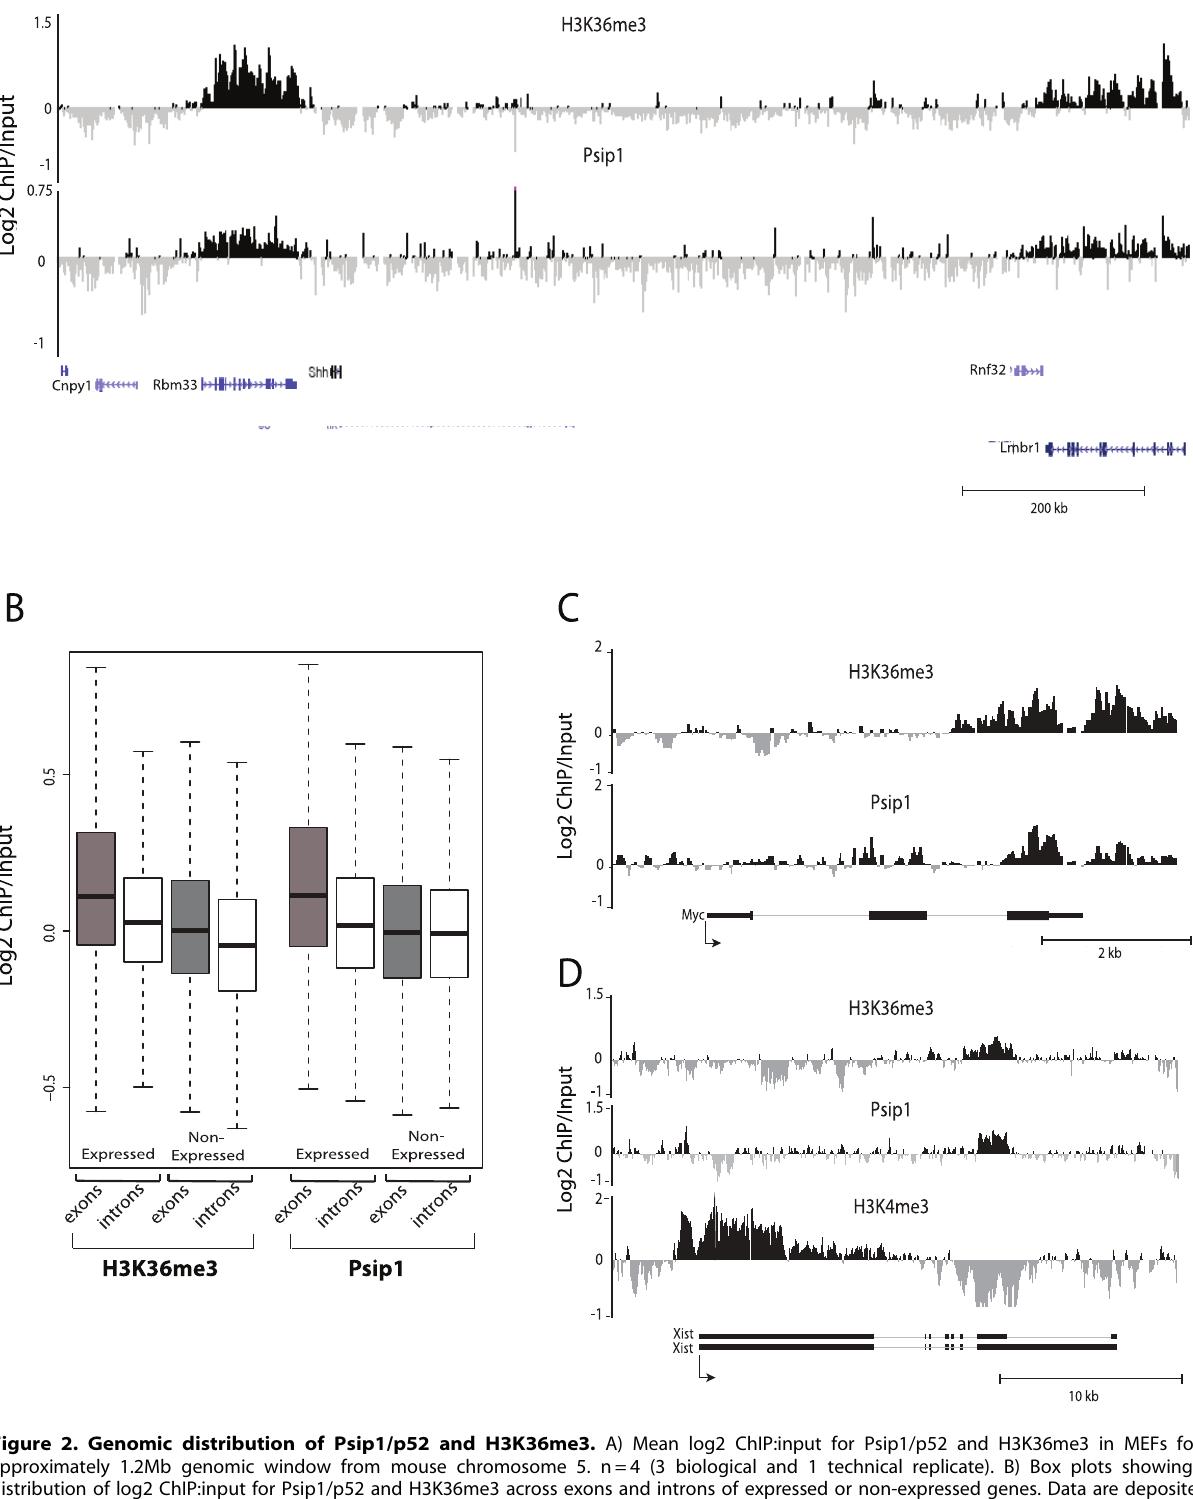
Figure 2. Genomic distribution of Psip1/p52 and H3K36me3. A) Mean log2 ChIP:input for Psip1/p52 and H3K36me3 in MEFs for an approximately 1.2Mb genomic window from mouse chromosome 5. n=4 (3 biological and 1 technical replicate). B) Box plots showing the distribution of log2 ChIP:input for Psip1/p52 and H3K36me3 across exons and introns of expressed or non-expressed genes. Data are deposited in NCBI GEO (Accession no. GSM697402-GSM697411). C, D) Mean log2 ChIP:input for Psip1/p52 and H3K36me3 in MEFs at (C) c- Myc and (D) Xist loci. H3K4me3 is also shown for XIST. Filled boxes indicate the positions of exons. n=4 (3 biological and 1 technical replicate) for H3K36me3 and Psip1. NCBI GEO accession number for array platform is GPL13276. n=2 biological: replicates for H3K4me3. doi:10.1371/journal.pgen.1002717.g002 PLoS Genetics |